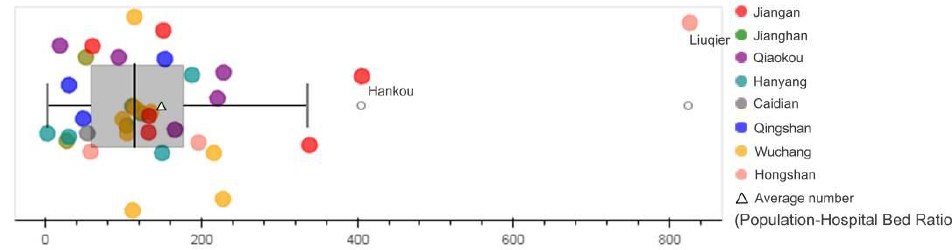
Figure 8. Population–hospital bed ratios of the designated hospitals (summary unit: district).